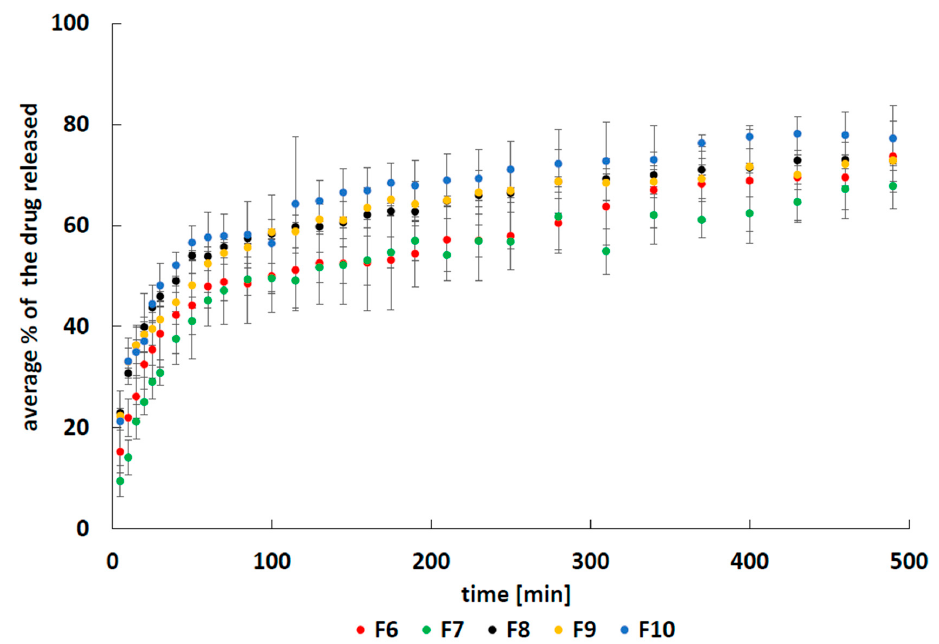
Figure 4. The release curves of 5 ‐ ASA from formulations F6–F10.